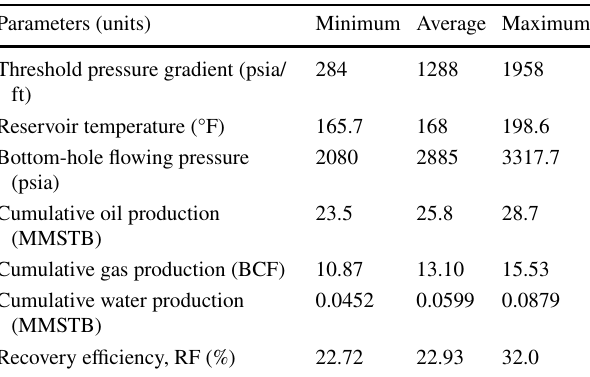
Table 3 Ranges of reservoir history data used for the well